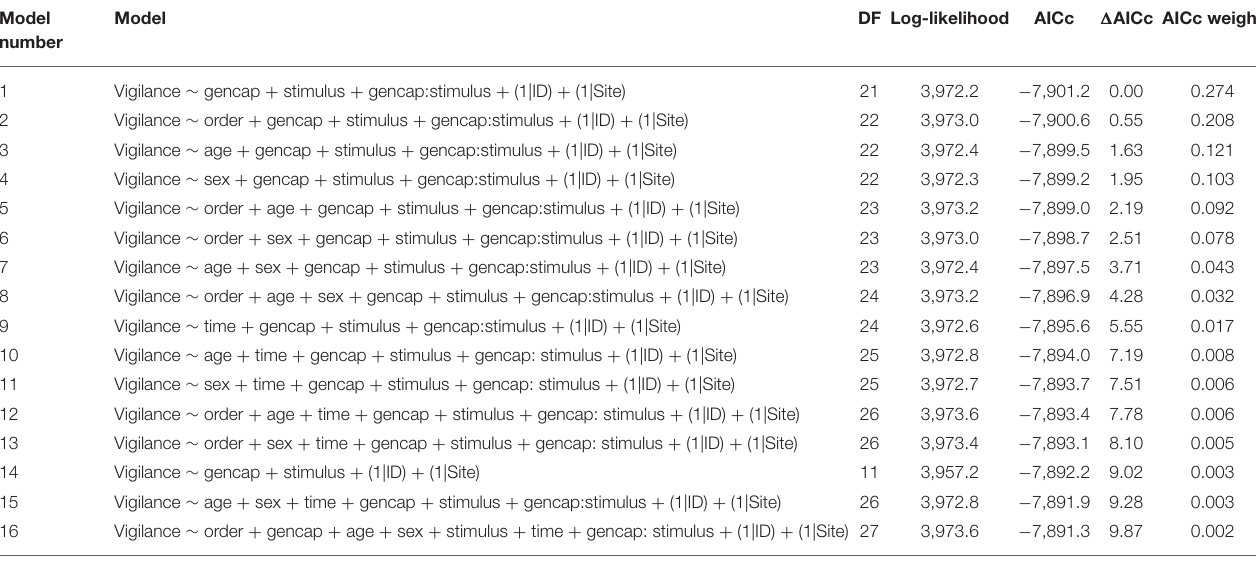
TABLE 1 | Candidate models for the proportion of time marmots allocated to vigilance or time in the burrow ranked by AICc weight, with degrees of freedom (DF), log-likelihoods, AICc values, 1 AICc values, and AICc weights. Model Model number